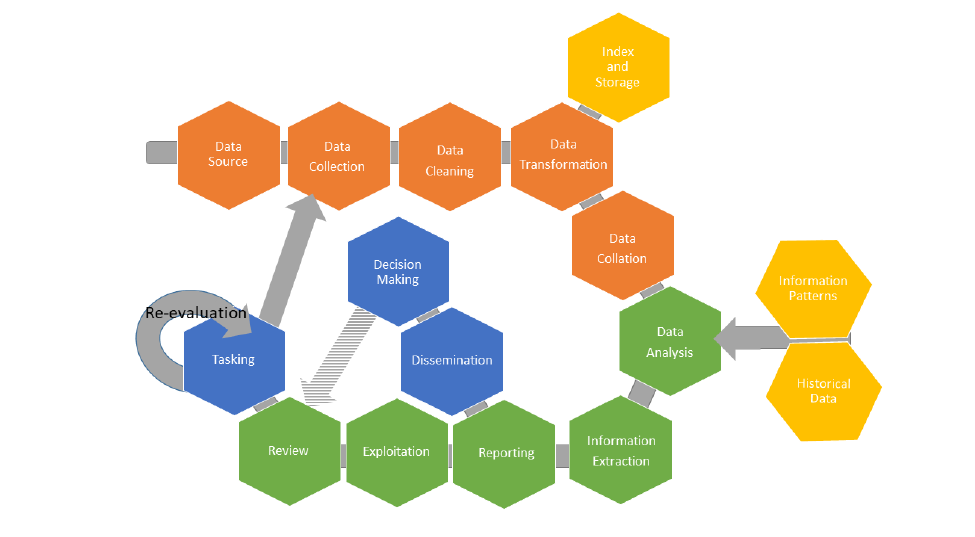
Figure 2. Information Life